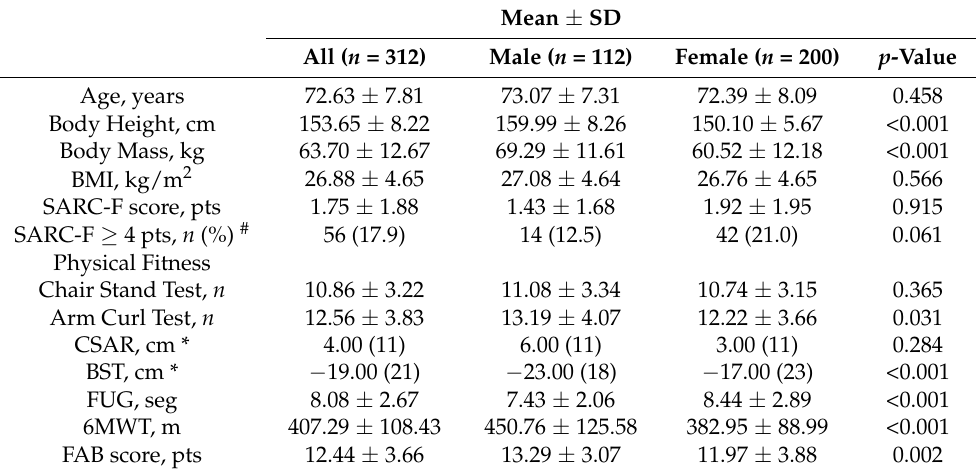
Table 1. Descriptive characteristics of the participants: mean ± standard deviation or median (interquartile range) *.